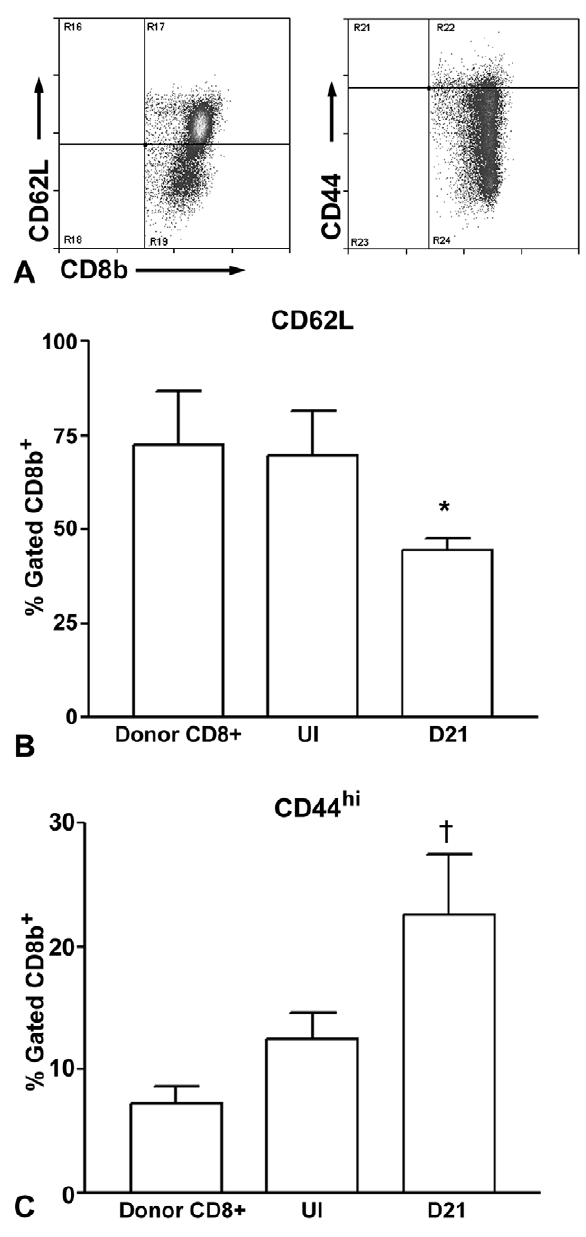
Figure 7. Characterization of cells transferred to recipient Rag- 1 2 / 2 mice. T cells enriched from pooled spleens of CD4 2 / 2 mice (Donor CD8 + ) were used for flow cytometric analysis and compared with T cells enriched from spleens of CD8 + T cell recipient Rag-1 2 / 2 mice 48 hours after cell transfer without injury (UI), and 21 days after injury (D21). Representative flow cytometric analysis of CD62L or CD44 gated on CD8b + cells from donor mice (A). CD8b + CD62L + (B) and CD8b + CD44 hi (C) cells T cells were compared between Donors (N=3), UI recipients (N=4) and D21 recipients (N=4). *P , 0.05 vs Donors and UI; { P , 0.01 vs Donors and UI.